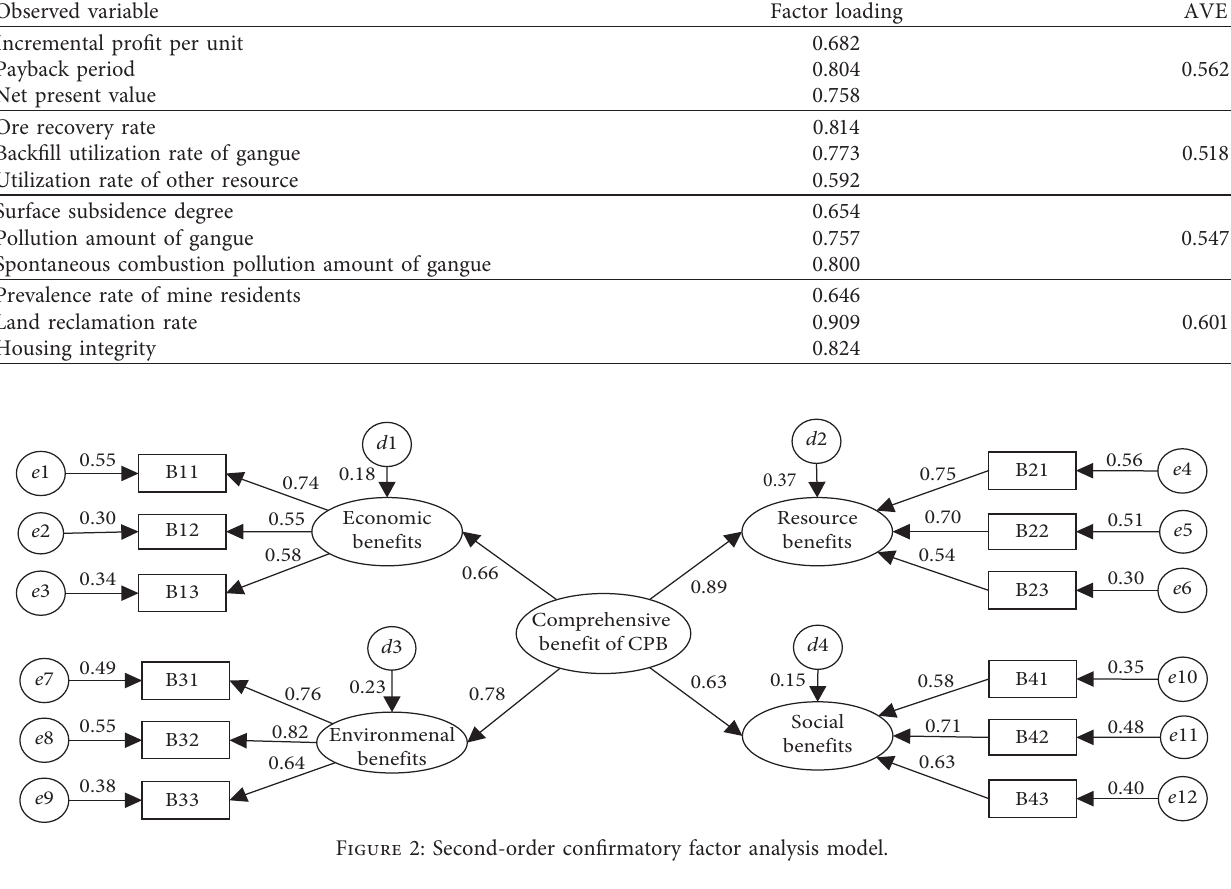
Table 4: Results of convergence validity.